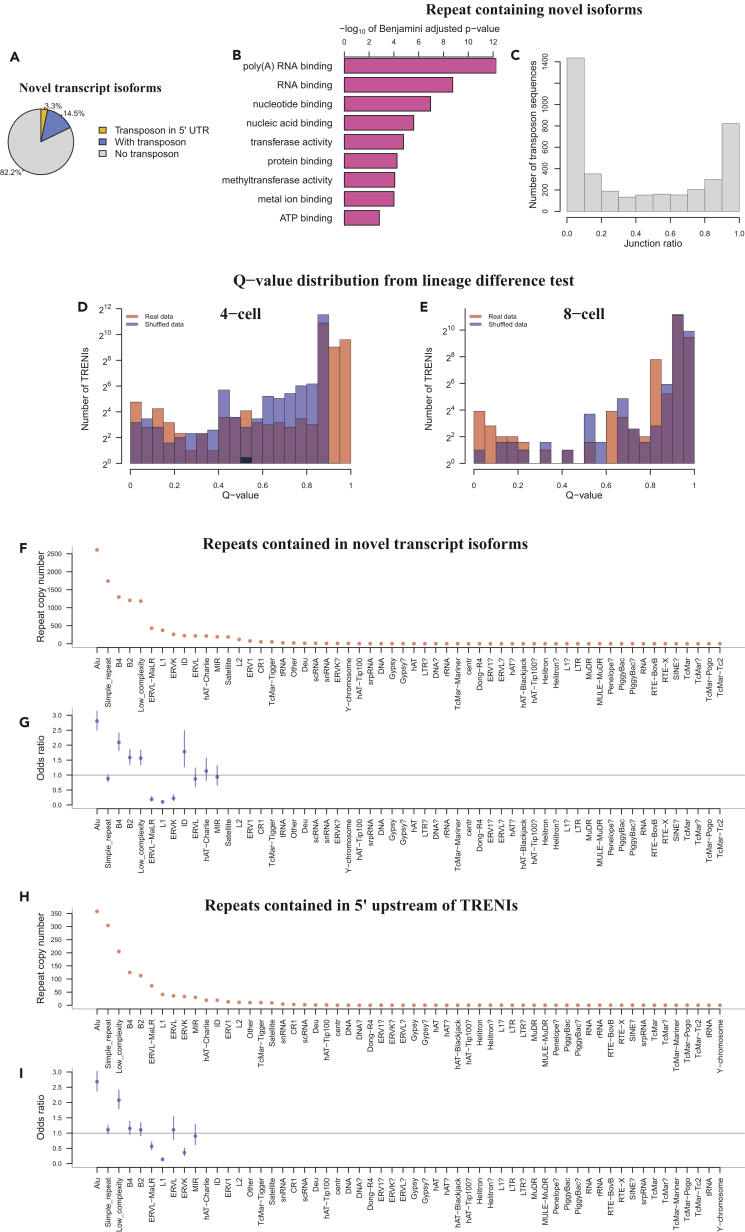
Transposon Related Novel Isoforms (TRENIs)(A) Pie chart of novel transcript isoforms, including 16,739 that do not contain any repeat sequence (gray) and 3,064 and 673 isoforms with transposons located downstream to start codons (blue) and in 5′ UTRs (yellow).(B) Enriched GO molecular functions in TRENIs, ranked by multiple hypothesis testing adjusted p values.(C) Histogram of junction ratios for all TRENI-containing transposons.(D and E) Histogram of TRENIs' q-values derived from tests of equivalent expression between lineages at 4- (D) and 8-cell (E) stages, based from real data (red) and shuffled data (blue).(F) Copy number of repeats contained in TRENIs, categorized by transposon family (columns).(G) Odds ratios between TRENIs and each repeat family (columns). Vertical bars: 95% confidence intervals. Odds ratio was not calculated for those repeat families when the TRENIs associated with a repeat family were fewer than 20.(H) Copy number of repeats contained in TRENIs' 5 UTRs, categorized by transposon family (columns).(I) Odds ratios between 5′UTR-TRENIs and each repeat family (columns). Vertical bars: 95% confidence intervals. Odds ratio was not calculated for those repeat families when the 5′UTR-TRENIs associated with a repeat family were fewer than 20.See also Figures S3–S6.